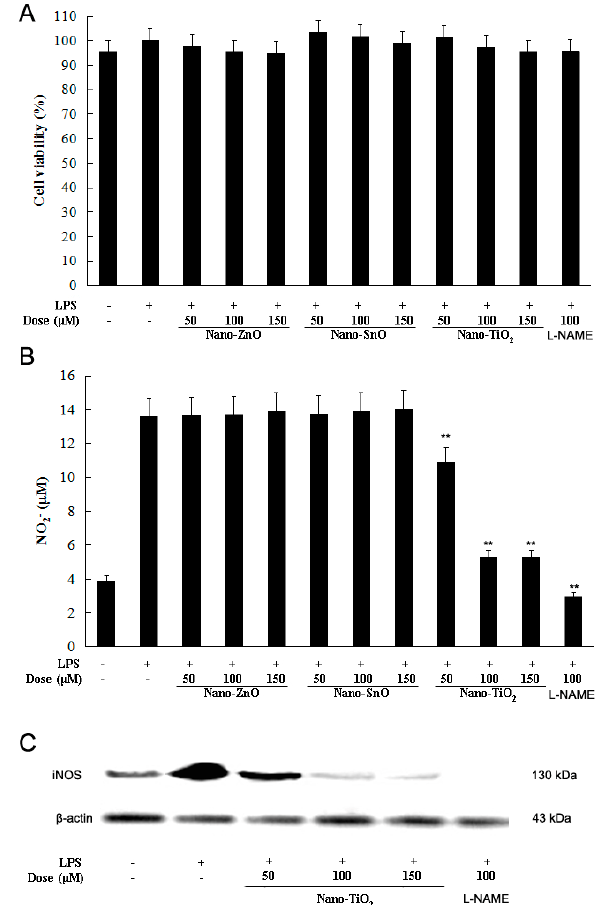
Figure 1. Effects of nano-TiO 2 on cell viability and nitric oxide (NO) production in LPS-induced RAW 264.7 mouse macrophages. After 24 h treatment, cell viability ( A ) was evaluated by MTT assay and NO production ( B ) was measured by the Griess reaction. Normal group was treated with media only. Control group was treated with LPS (100 ng/mL) alone. Data were shown as means ˘ standard deviation (SD) of three independent experiments. ** p < 0.01 against control group; ( C ) The expression of iNOS was dectected by Western